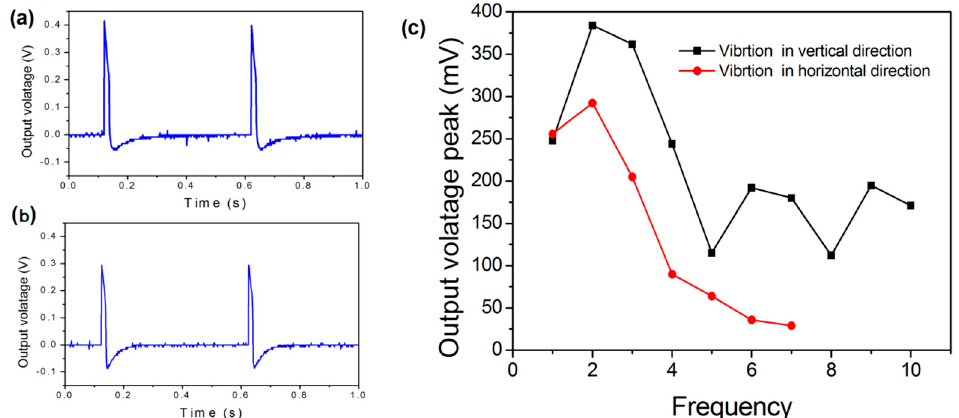
Figure 9. Performance of microfluidic energy harvester. ( a ) Output voltage of energy harvester after